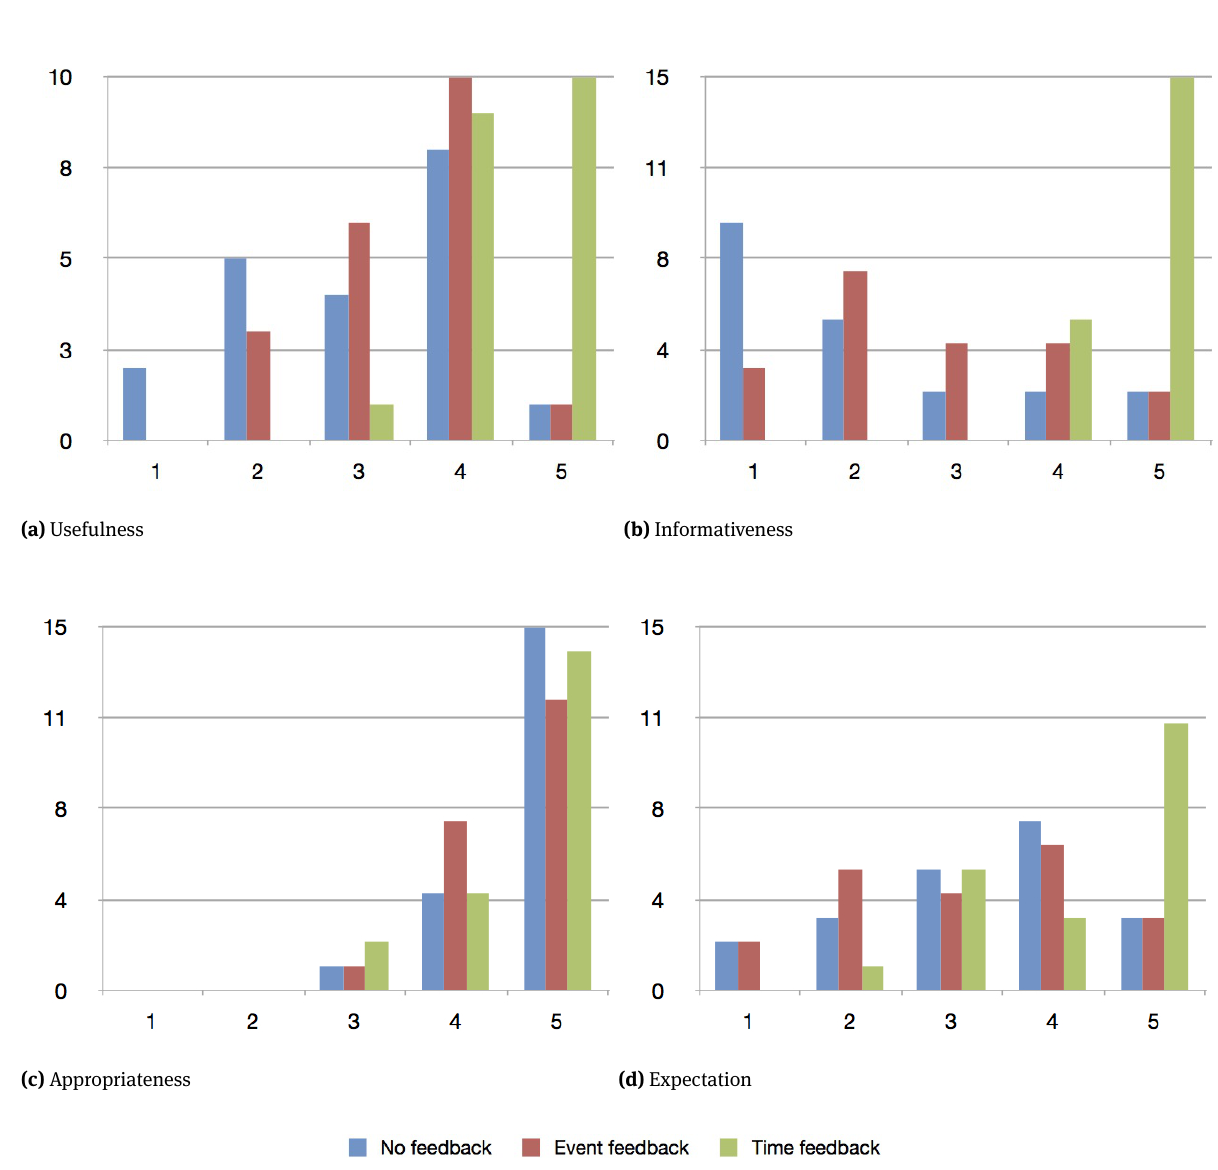
Figure 2: Likert-scale questionnaire responses (1 = strongly disagree - 5 = strongly